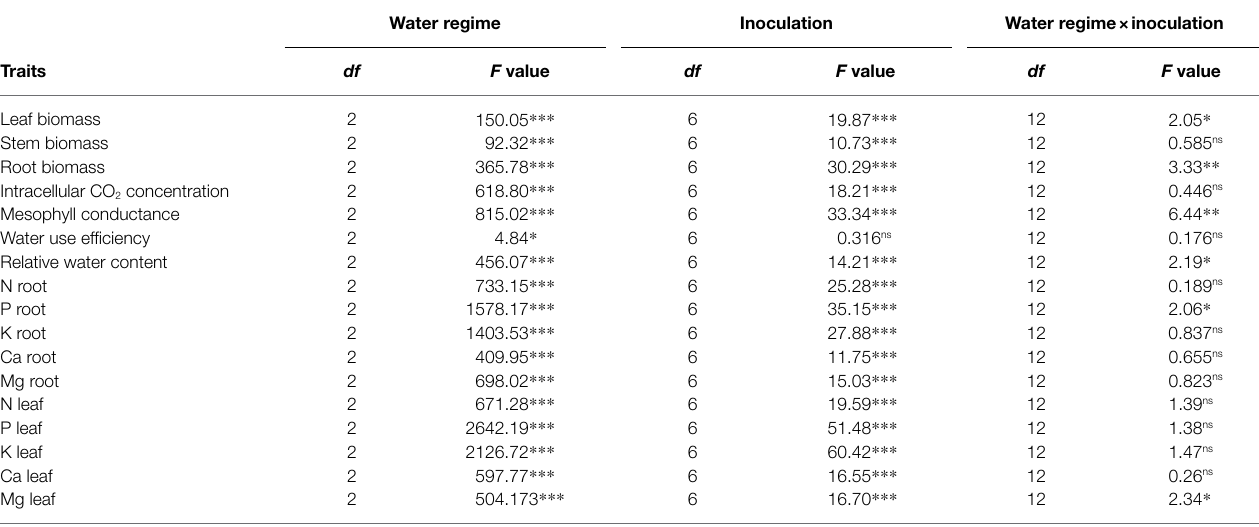
TABLE 2 | Results of a two-way ANOVA testing the effect of microorganism inoculation on biomass allocation, water relations, and elemental concentration of M. communis seedlings under three different water regimes (100, 60, and 30% of field capacity). Water regime